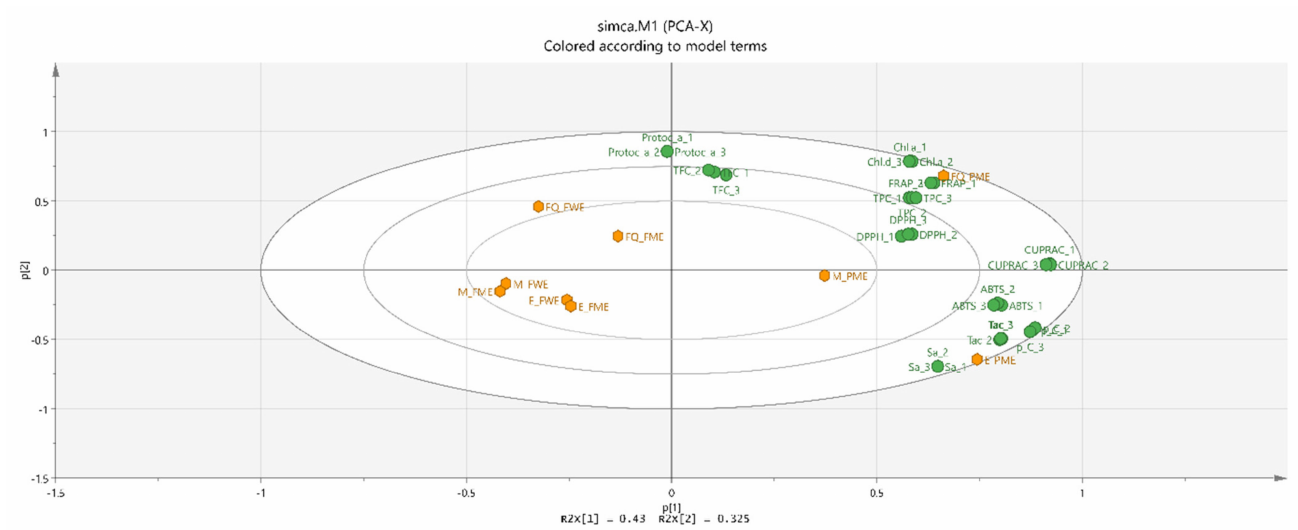
Figure 4. Biplot of PCA analysis of phytocomponents in late season peach ( Prunus persica L.) varieties.M—“Morsiani 90”; FQ—“Flat Queen”; Evm—“Evmolpiya” varieties; WFE—water peach extract, MPE—methanolic peach-peel extract, MFE— methanolic peach extract; TPC_1-3—total phenolic content; TFC_1-3—total flavonoid content; Tac_1-3—total monomeric anthocyanin content; DPPH_1-3—DPPH radical scavenging assay; ABTS_1-3—radical scavenging assay; FRAP_1-3—ferric- reducing antioxidant power assay; CUPRAC_1-3—cupric ion-reducing antioxidant capacity; protoc. a_1-3—protocatechuic acid; Chl.a_1-3—chlorogenic acid; p_C_1-3—p-coumaric acid; Sa_1—sinapic